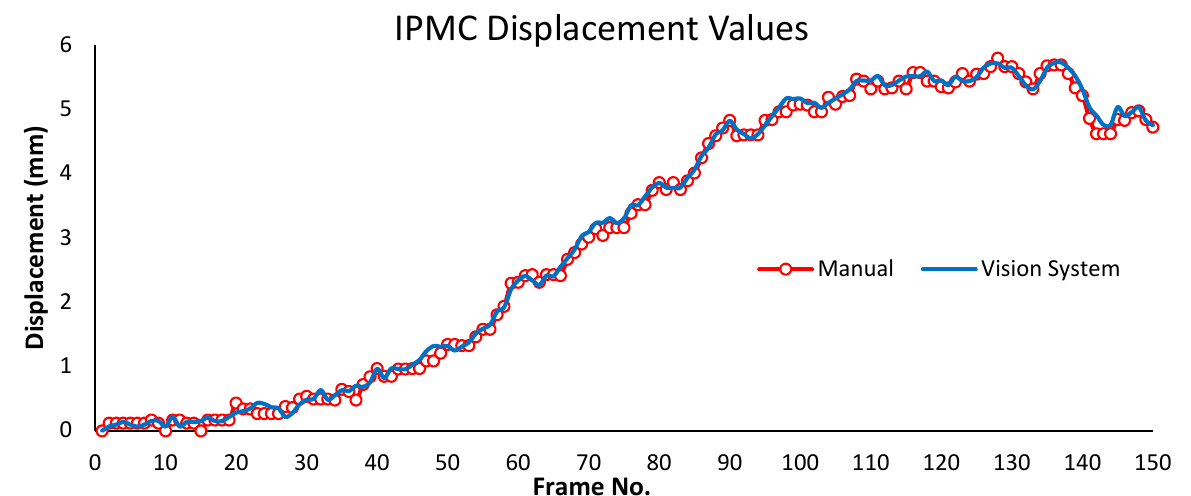
Figure 18. IPMC displacement values obtained from manual calculation and vision system. Visually inspecting the displacements values obtained from both methods, the results generally follow the same trend with no significant deviations between one another. Deviations in results between the manual method and the proposed vision system can statistically be calculated using mean absolute error (MAE) and root mean squared error (RMSE). Calculated values of MAE and RMSE are 0.068080668 and 0.088160652, respectively. A similar trend can be seen in bending angle values, as shown in Figure 19.